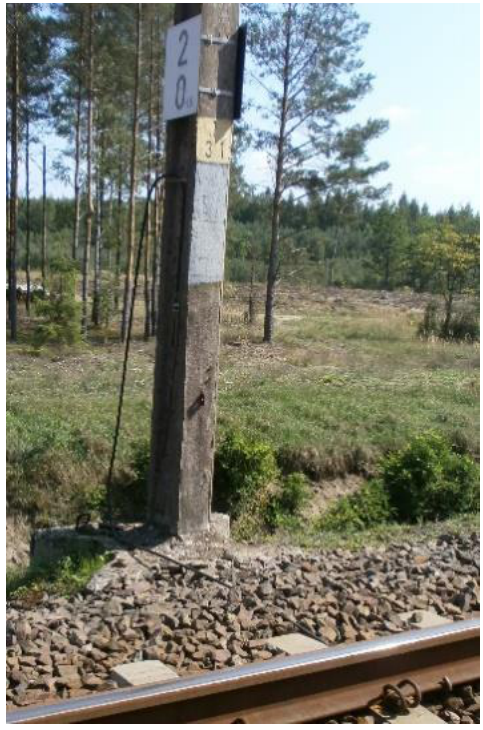
Figure 3. Return network of a DC traction system in object Nos. R 143_1_1 and R 143_1_2 .